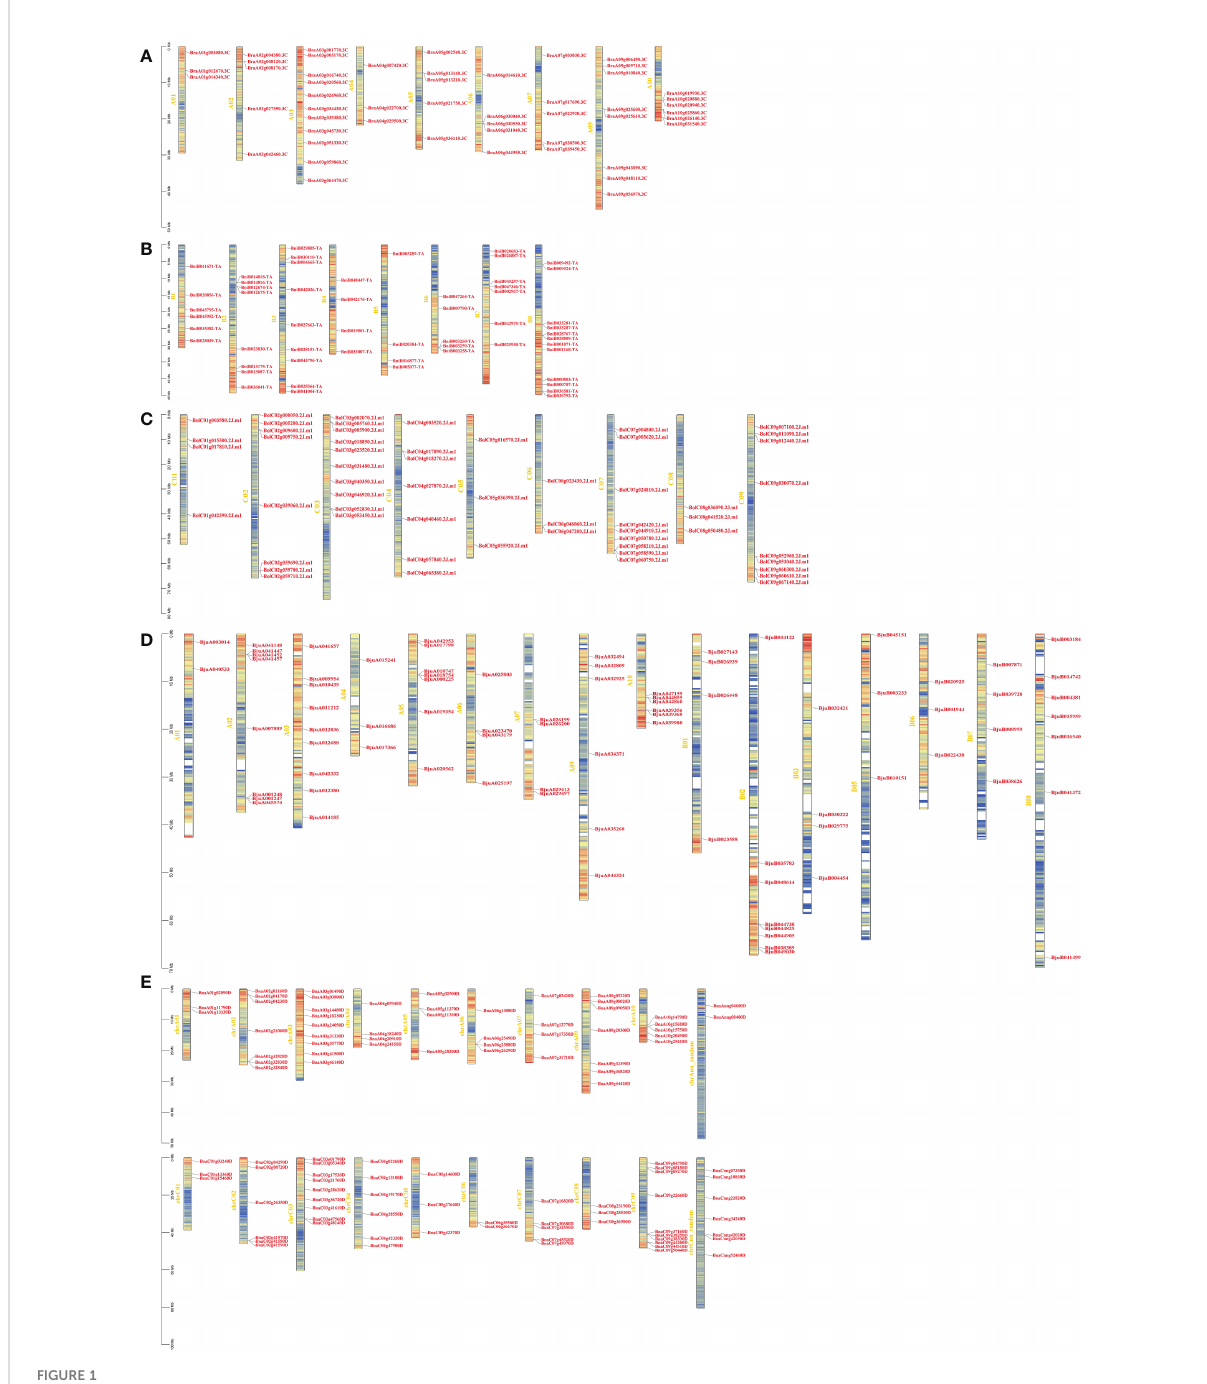
FIGURE 1 Locations of CPK genes on chromosomes in fi ve Brassica species. Locations of CPK genes in B rapa (A) , B . nigra . (B) , B . oleracea (C) , B . juncea (D) , and B . napus (E) , respectively. A01-A10, B1-B8, C01-C09, A01-B08, and chrA01-chrCnn represent the chromosomes in B rapa , B . nigra , B . oleracea , B . juncea , and B . napus , respectively. Red indicates high gene density, while blue indicates